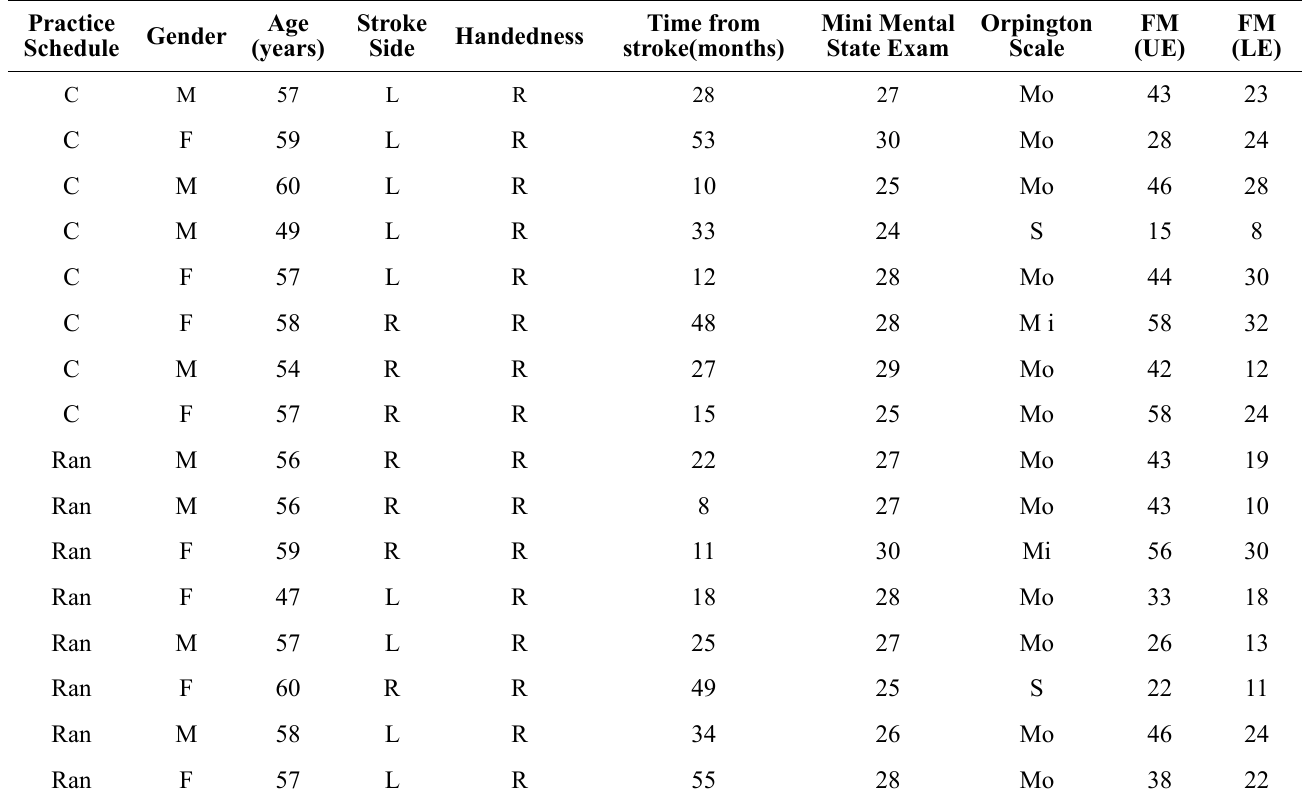
Table 1: Characterization of the experimental